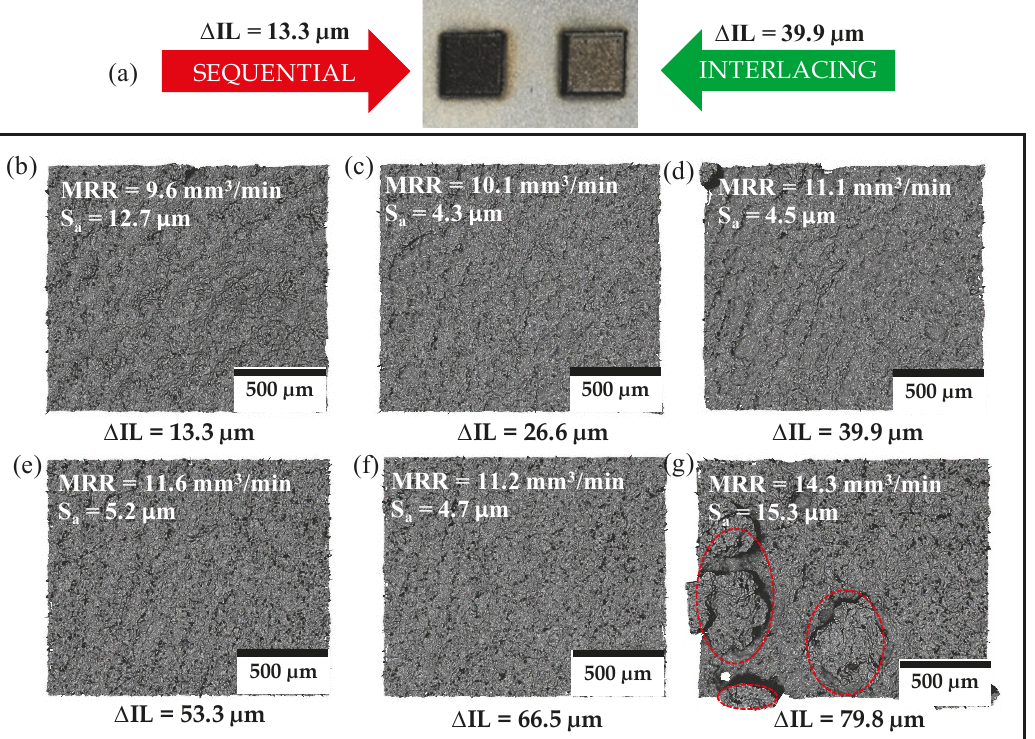
Figure 8. ( a ) Photograph comparing sequential method (SM) to interlacing method (IM). ( b ) Surface morphology for SM. ( c – g ) Surface morphology at di ff erent interlacing distances ( ∆ IL), produced at a scan speed of 1900 mm / s, 280 ns and ED A = 4.2 J / mm 2